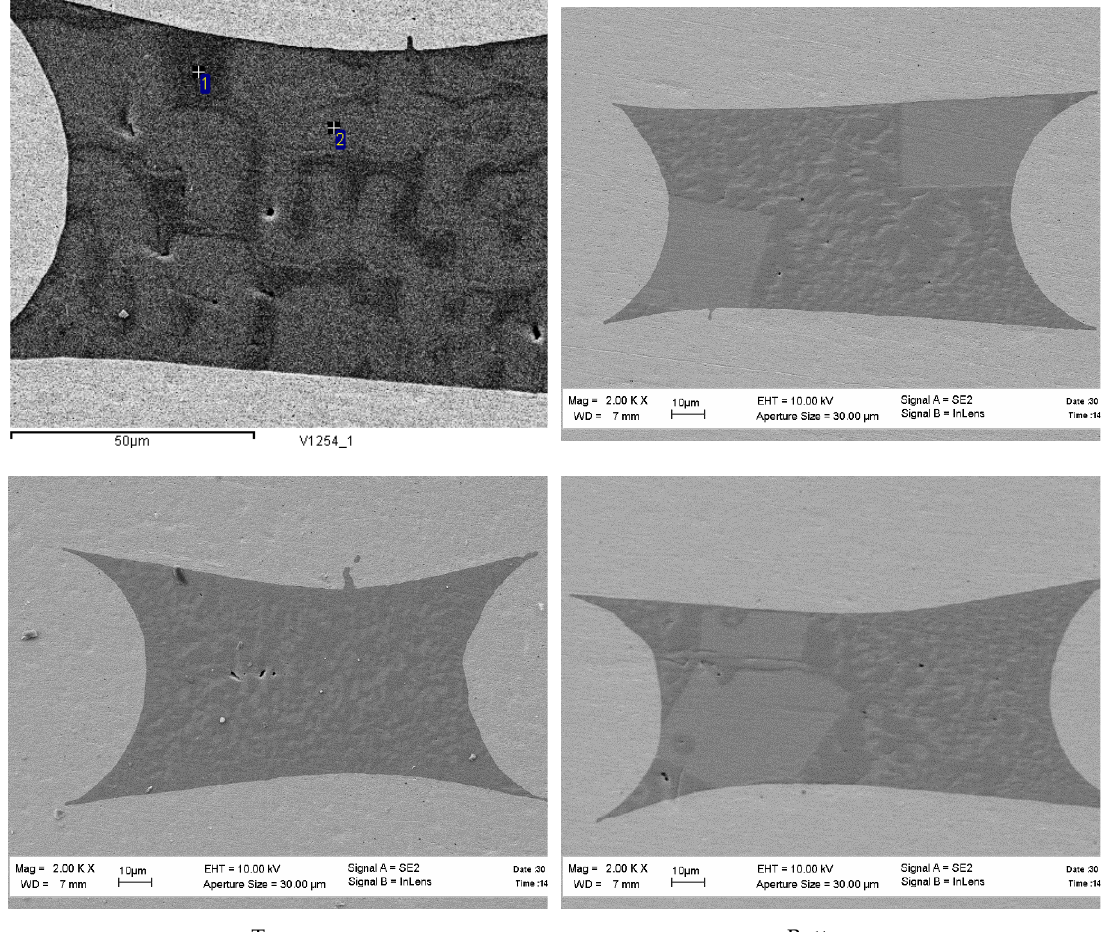
Figure 7. SEM micrographs of the cross-sections of the composite specimen V1254 crystallized at a rate of 50 mm/min according to the first crystallization scheme from the raw oxide mixture sintered at 1650 ° С for 5 h. Note a difference between the fiber microstructures at top and bottom of the oxide/molybdenum block.